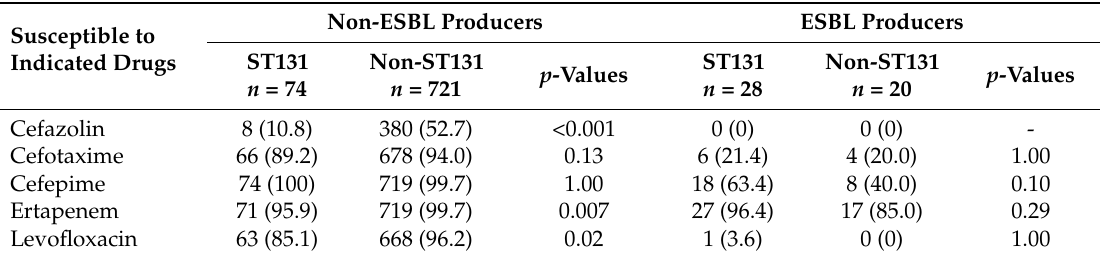
Table 3. Susceptibility profile* of community-onset bacteremic Escherichia coli isolates, categorized by ESBL production and ST131